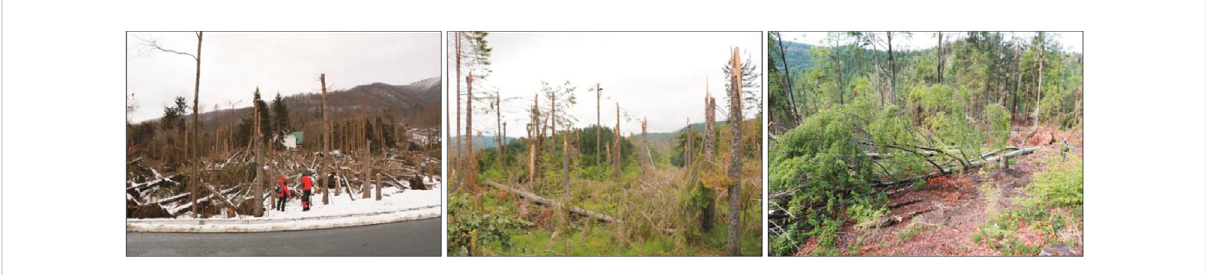
FIGURE 4 Field survey photo for the damaged stands (photo Hotea M,